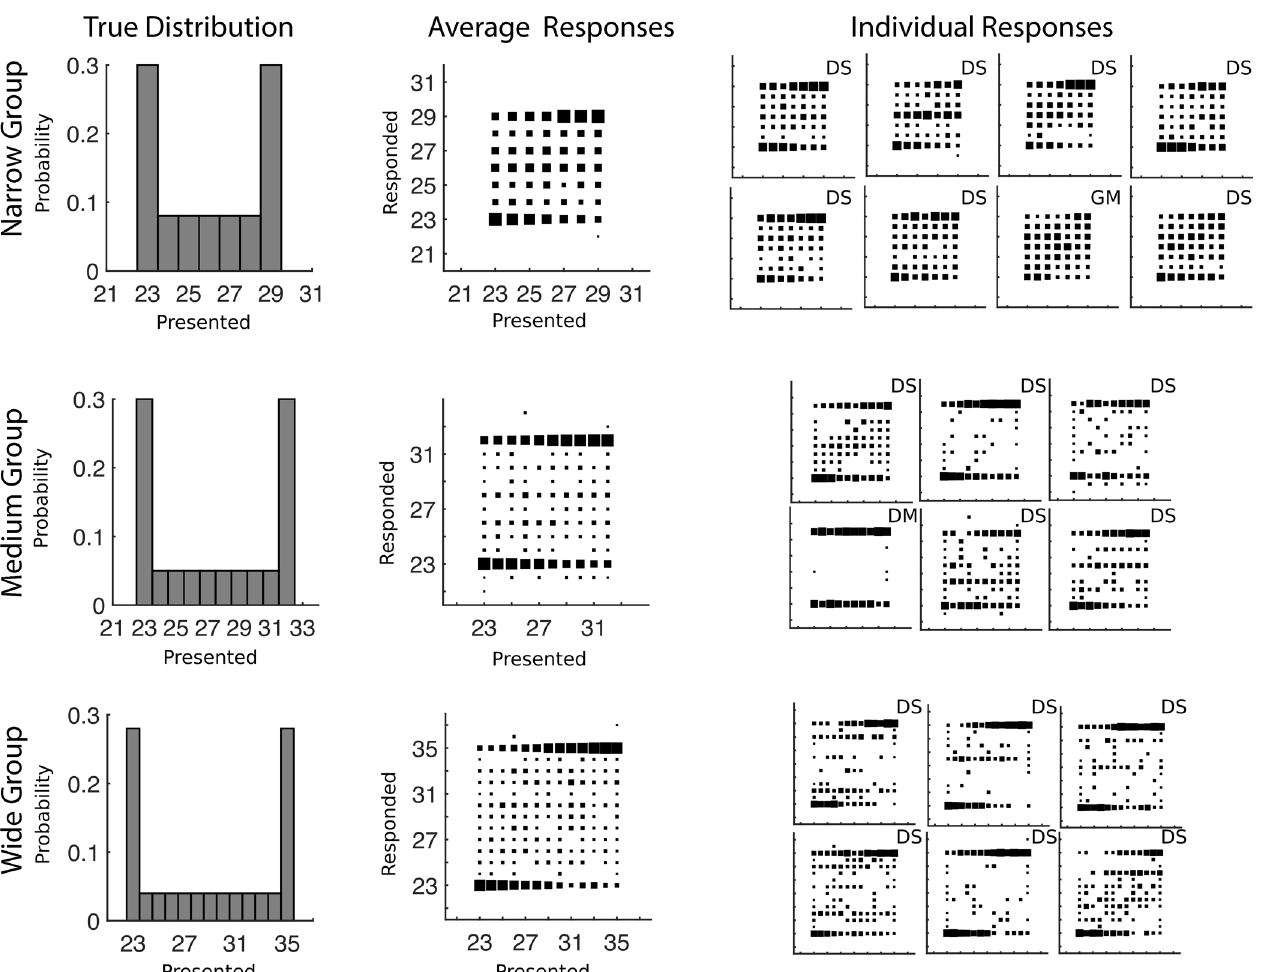
Fig 3. Training distributions and conditional response distributions for each group of participants after 300 trials in Experiment 1. Each group of participants is in a separate row. The left column of plots shows the probability with which each number was presented to participants. The middle column shows aggregate conditional response distributions with the area of each square representing the relative frequency of making a particular response given a particular presented stimulus. The right column shows the conditional response distributions for each participant. The letters D and G mark participants who are using a categorical (Dirichlet prior) or Gaussian kernel prior respectively and the letters A, M, and S mark the participants who were characterized as using the mean (Average), Max, or Sampling decision functions